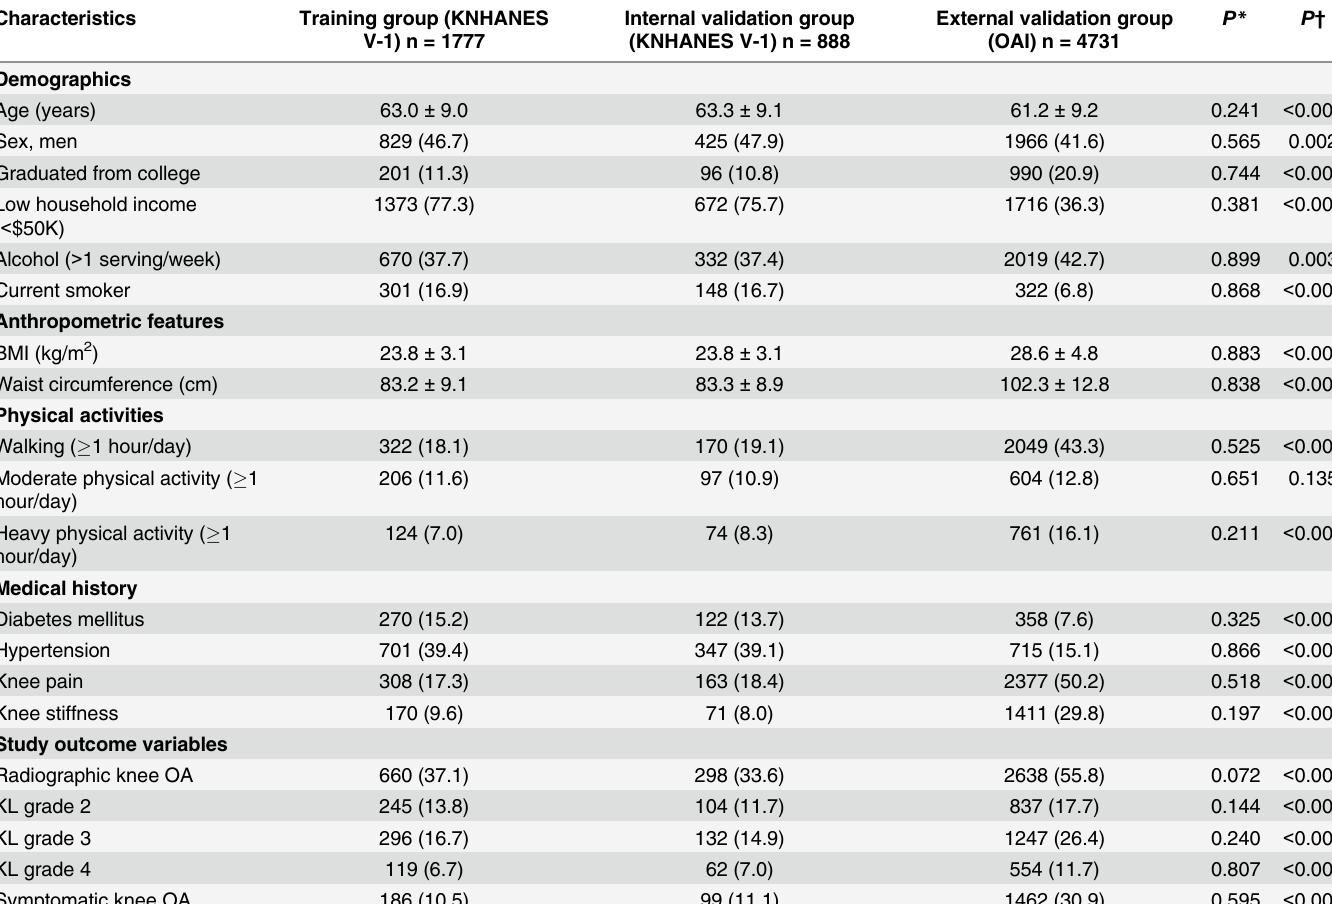
Table 1. Clinical characteristics of participants of the training, internal validation, and external validation groups.